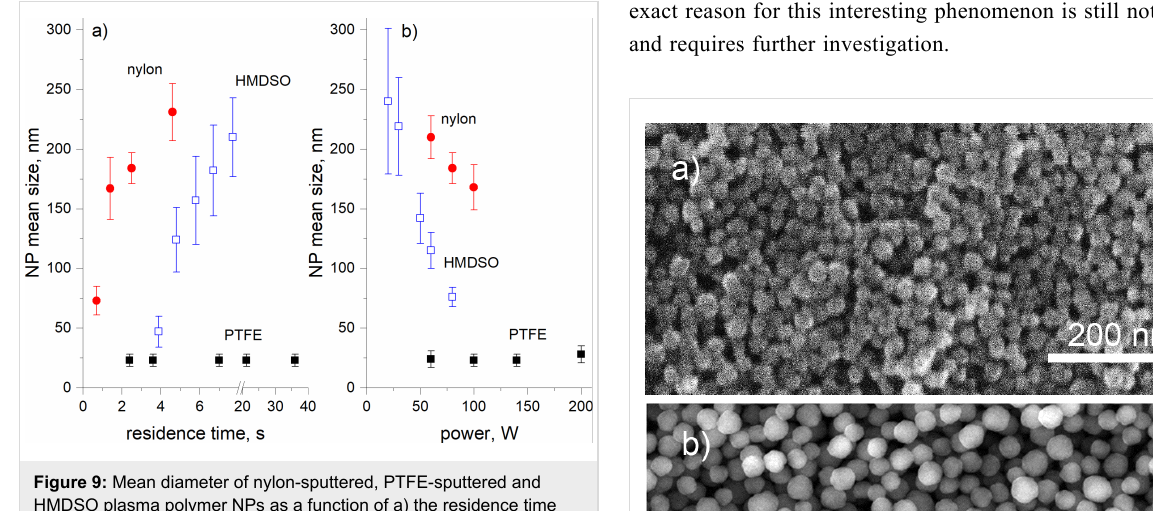
and requires further investigation.